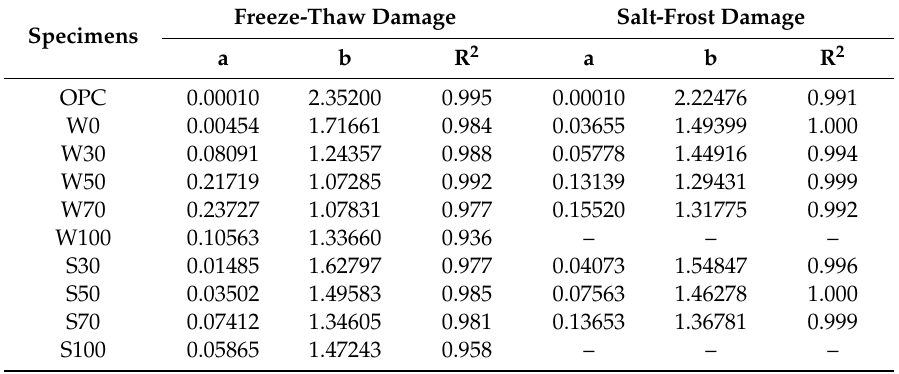
Table 4. Salt and water freezing damage power function parameters of ACSC. Table 4. S alt and water freezing damage power function parameters of ACSC.